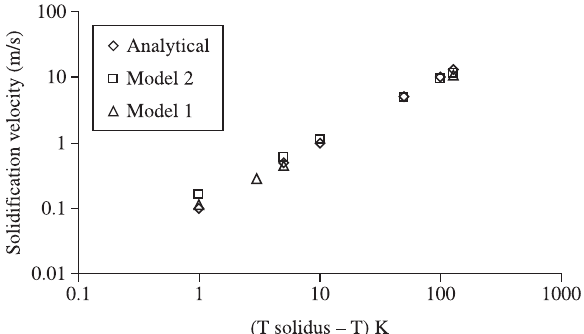
Figure 4. Solidification velocity of Ni-0.05 mole fraction of Cu as a function of undercooling; a comparison of results from different phase field models and the analytical solution of sharp interface model: Model 1 means present work based on Kim et al. 6 ; Model 2 means present work based on Ramires et al. 7 .